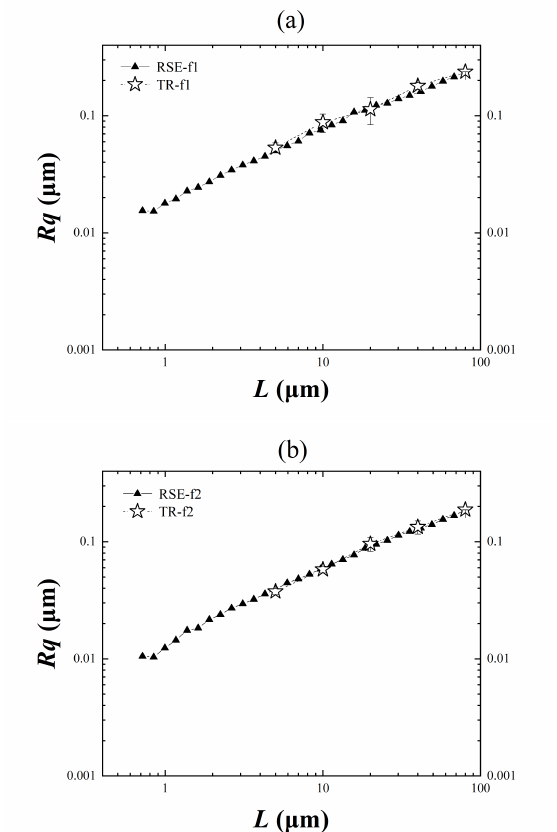
Figure 10. ( a ) Rq - L curves calculated with RSE-f1 and TR methods; ( b ) Rq - L curves calculated with RSE-f2 and TR